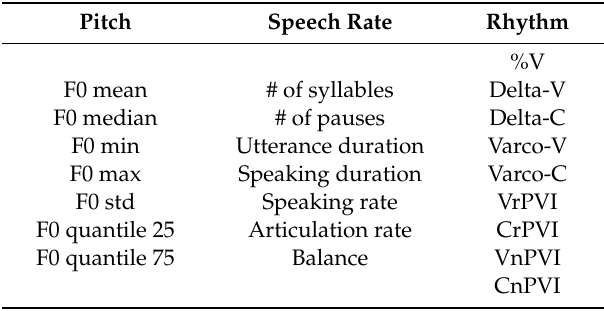
Table 1. The full set of prosody-based